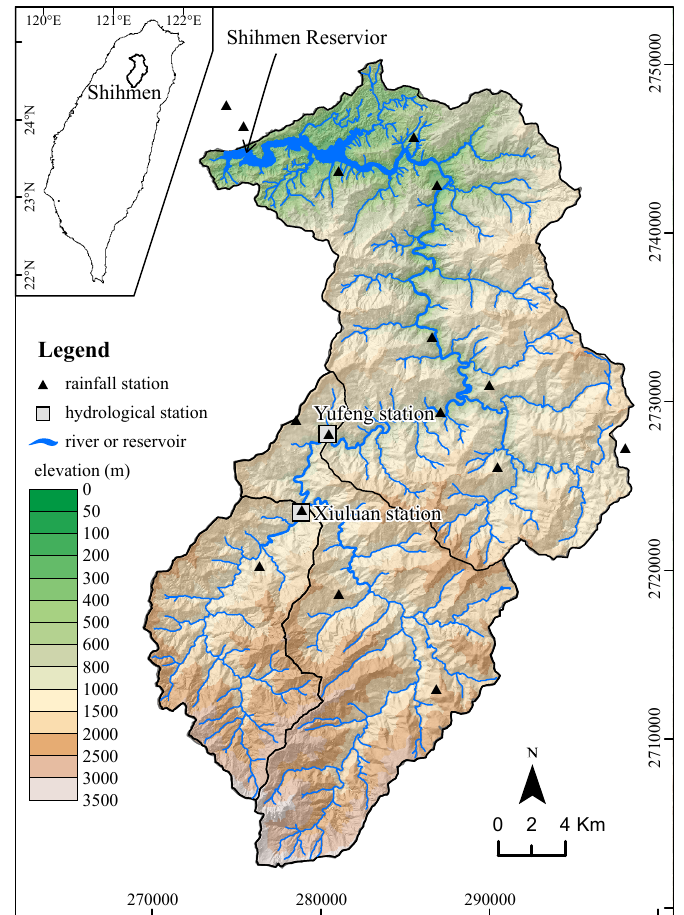
Figure 1. Shihmen Reservoir watershed and the watersheds of interest. The measurements of riverflow and sediment discharges at Yufeng and Xiuluan stations were used for verification. The watersheds upstream to Yufeng and Xiuluan stations are marked by solid black